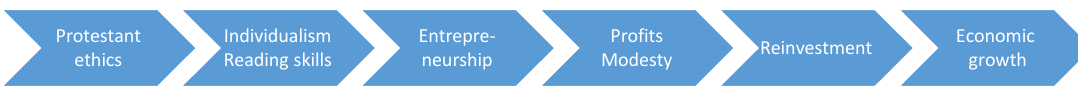
Figure 1. Weber’s algorithm on link between protestant ethics and economic growth